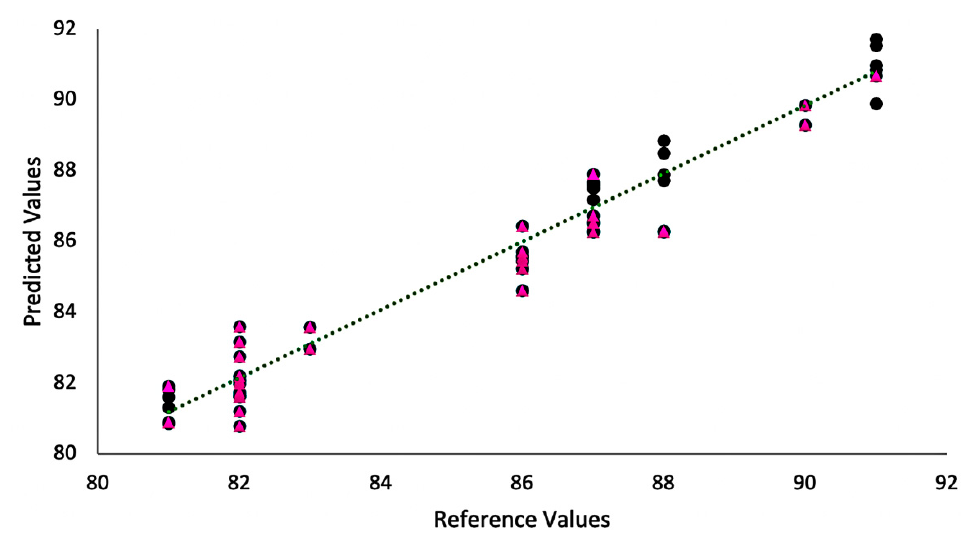
Figure 4. Experimental (black circles) vs. predicted values (pink triangles) obtained by the models based on NIR